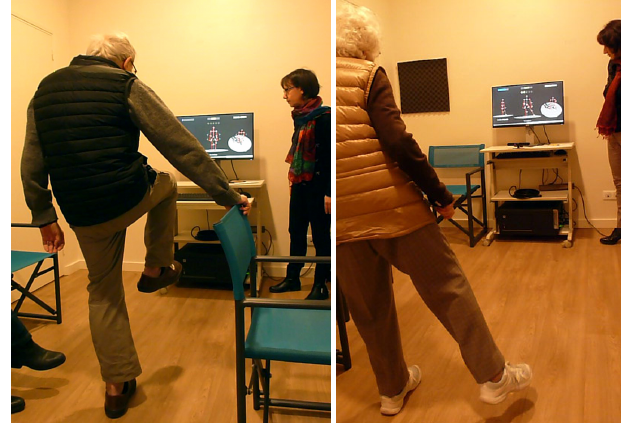
Figure 2. Overview of the KINOPTIM system during two exergames ( Left : knee extension; Right : sideway right leg lift). The experimental room is equipped with technical